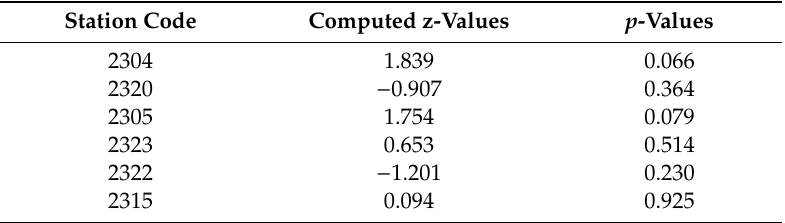
Table 2. The Mann–Kendall test for 7-day low-flow